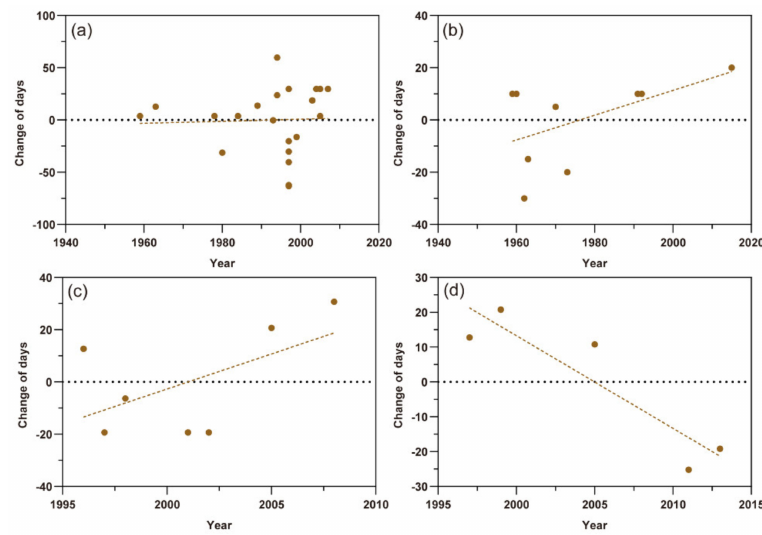
Figure 4. Scatter plots of the last migration times of three aphid pests. The dots represent di ff erent records and the dashed lines show the trends of the last flight migration. ( a ) Myzus persicae ; ( b ) Sitobion avenae ; ( c ) Aphis gossypii in northern Xinjiang; ( d ) A. gossypii in southern Xinjiang.